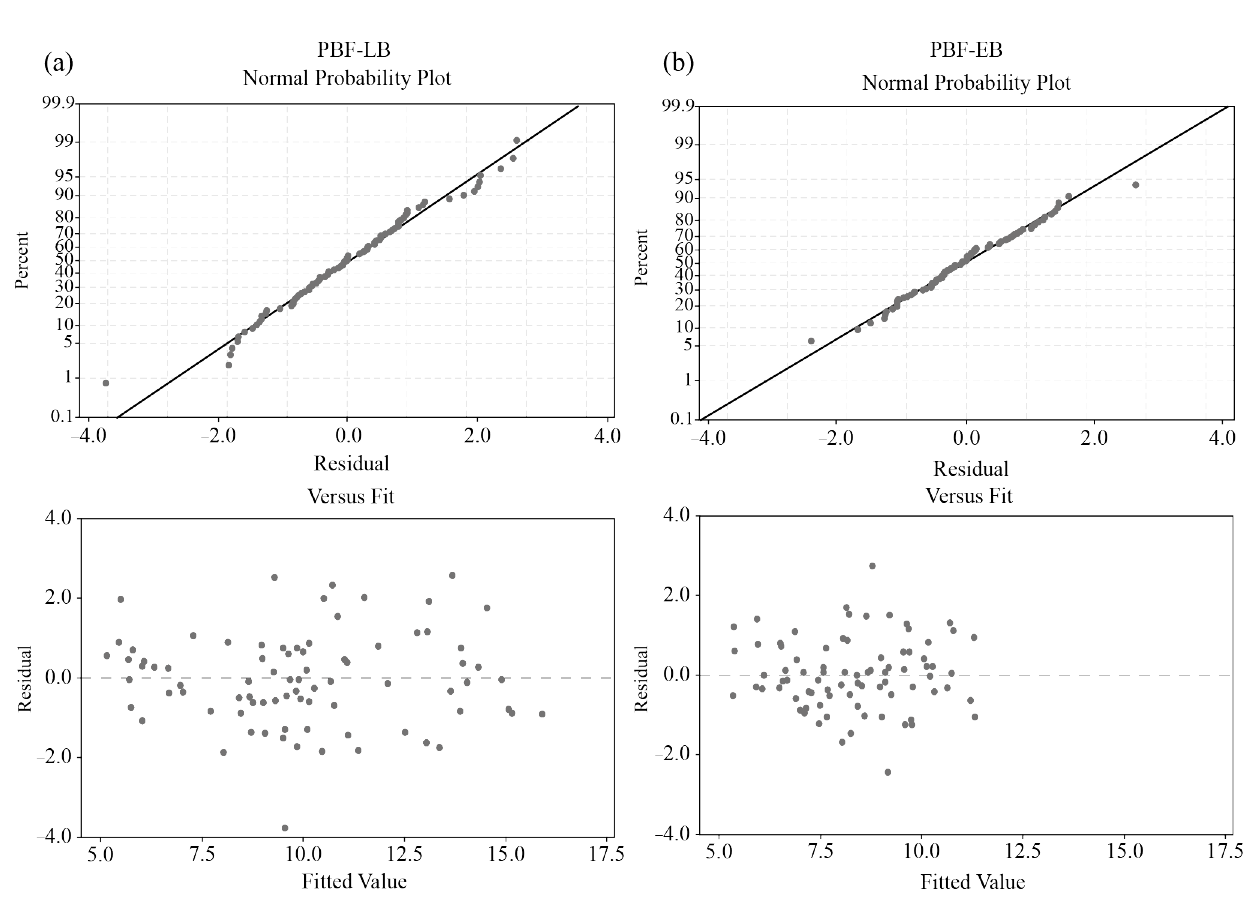
Figure 7. Residuals plots of the V c regressions models for ( a ) PBF-LB and ( b ) PBF-EB.